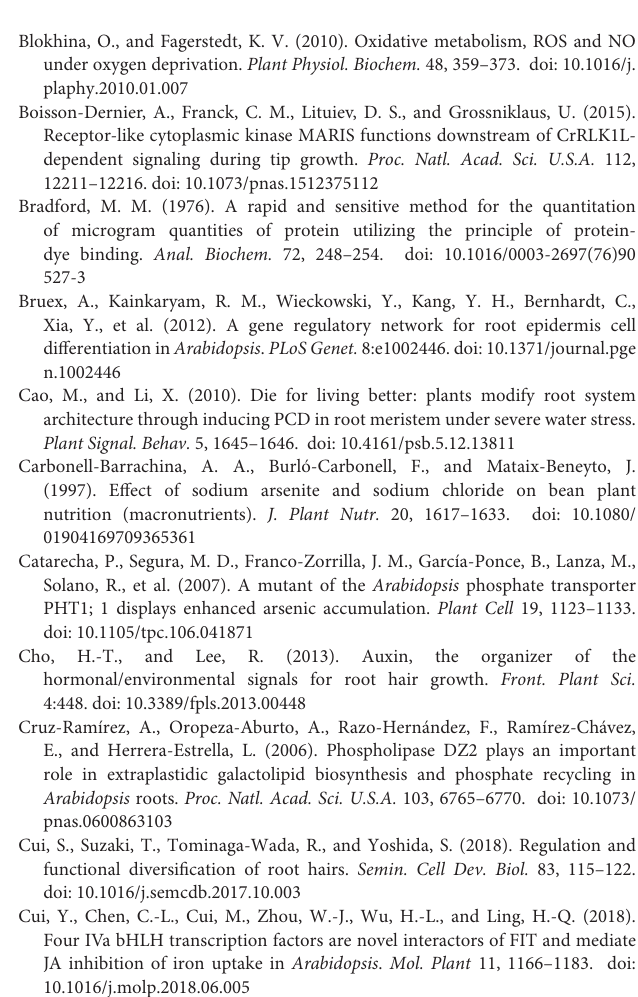
Supplementary Table 6 | As-, Hpx- and HpxAs-induced significant transcriptional deregulation for cytochrome P450 genes associated with redox regulation of root growth. Supplementary Table 7 | Transcript deregulation for genes related to glucosinolate